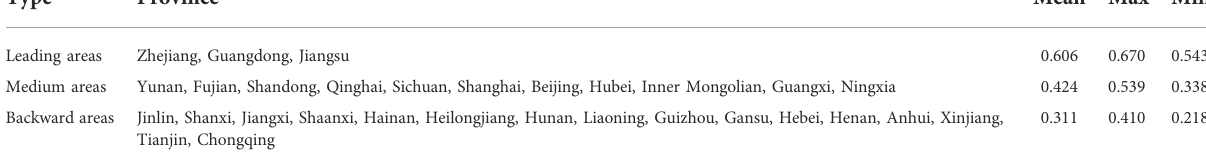
TABLE 3 Clustering